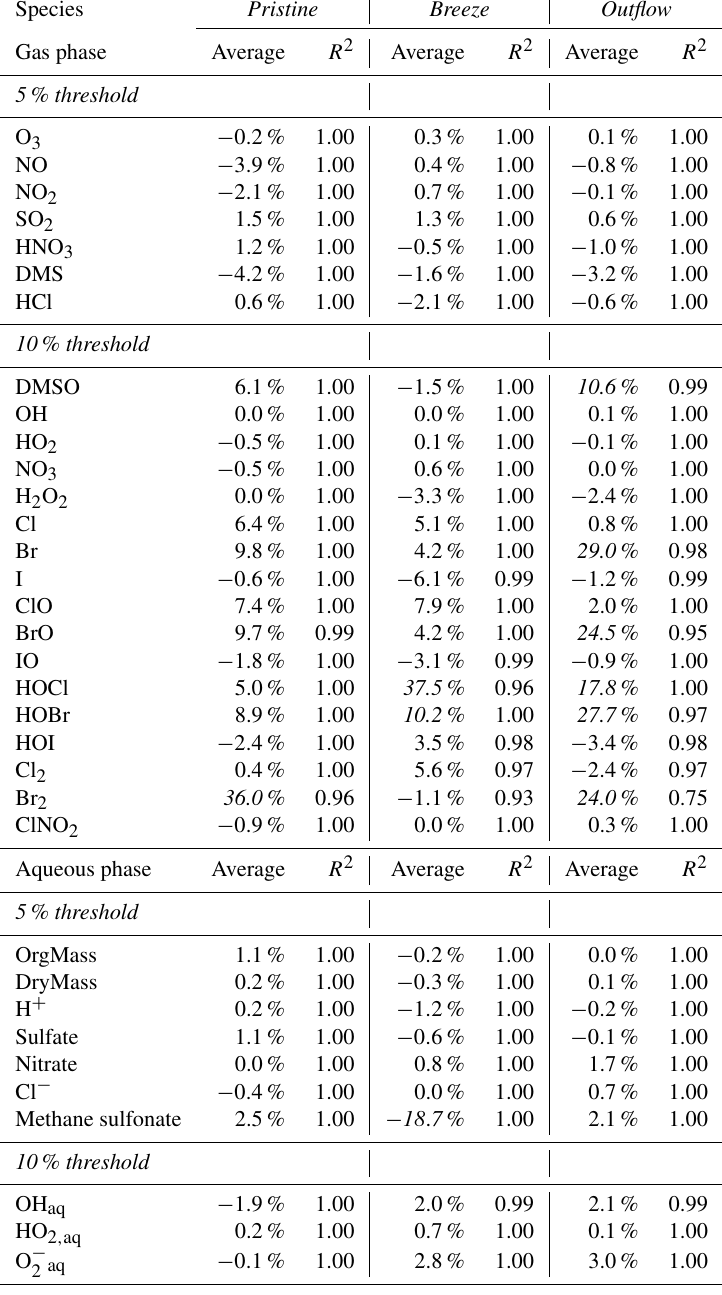
Table 1. Average percentage deviations (%) of some inorganic and organic target compounds between the simulations with the full and re- duced CAPRAM-DM1.0 and CAPRAM-HM3.0 mechanisms (deviations calculated throughout the full SPACCIM simulation). Exceedances of the threshold are marked in